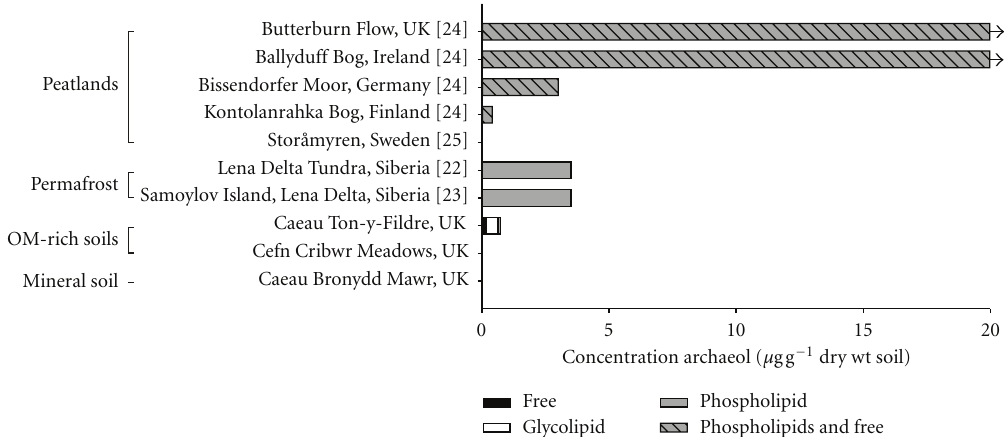
Figure 5: Concentration of archaeol in peat, permafrost and oxic soils (references in square brackets): free (black), glycosidic-bound (white), phospholipid-bound (grey), phospholipids and free